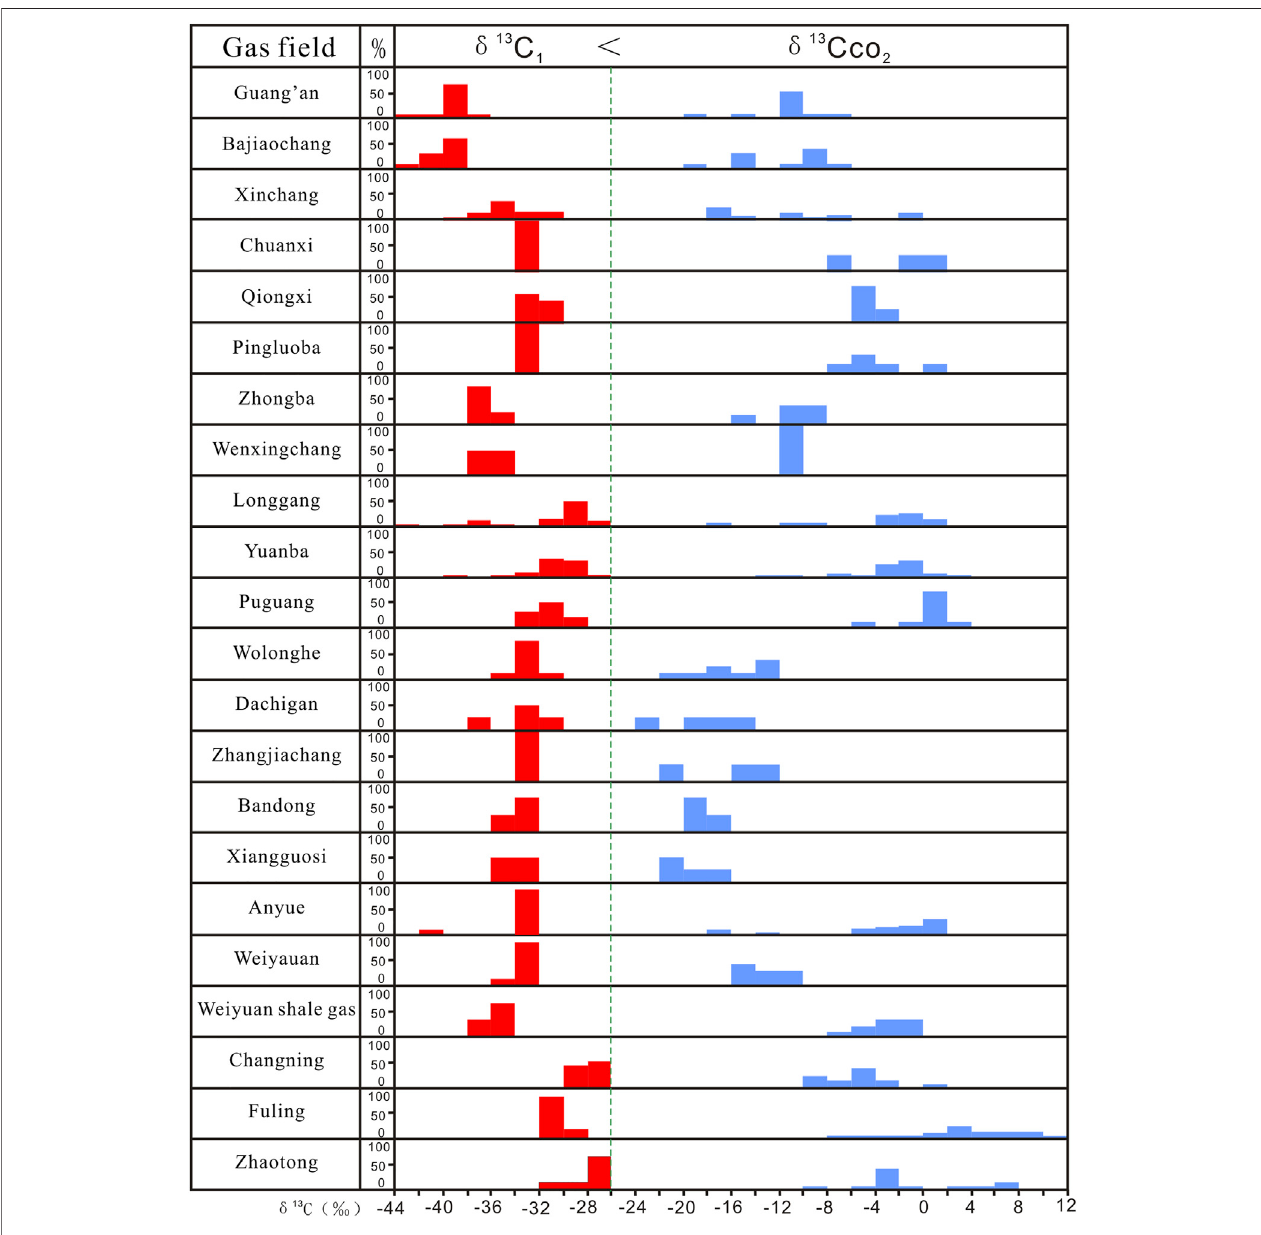
FIGURE 9 | Comparison of carbon isotopic value of methane and CO 2 in natural gas from the Sichuan Basin.